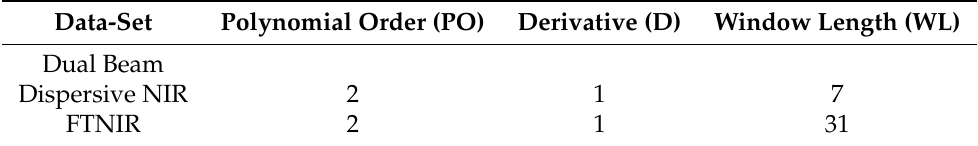
Table 1. Parameters for Savitzky-Golay (SG) Filter.